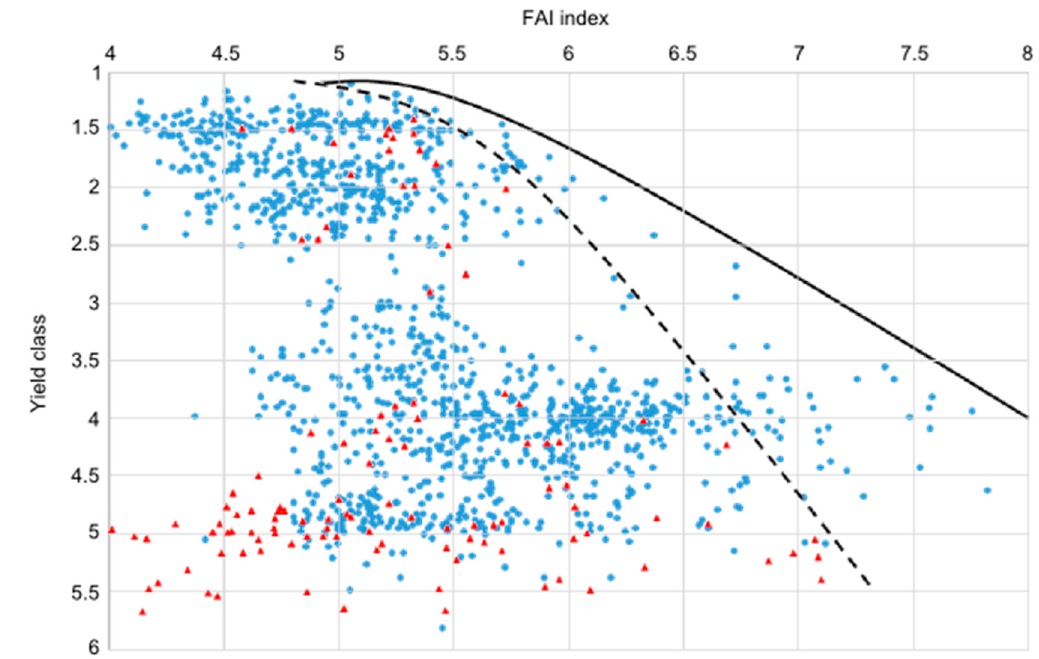
Figure 9. Envelope curves of forest inventory data indicate the role of soil conditions in limiting the presence of sessile oak under changing climate. Climate characterized by FAI values is set against yield class of stands on shallow soils (red triangles and dashed line), and on deeply rooted soils (blue circles with solid line). X-axis: Forest Aridity Index from humid (4) to dry (8) sites; Y-axis: Yield classes from the best (1) to the worst (6) class (G. Illés, original).